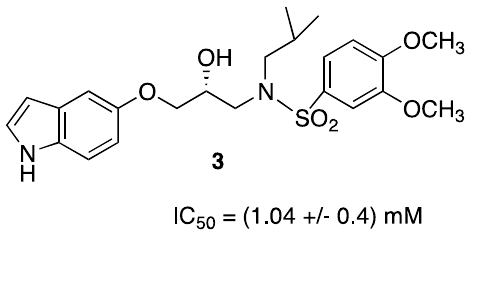
Figure 3. Structure of indolic non-peptidic HIV protease